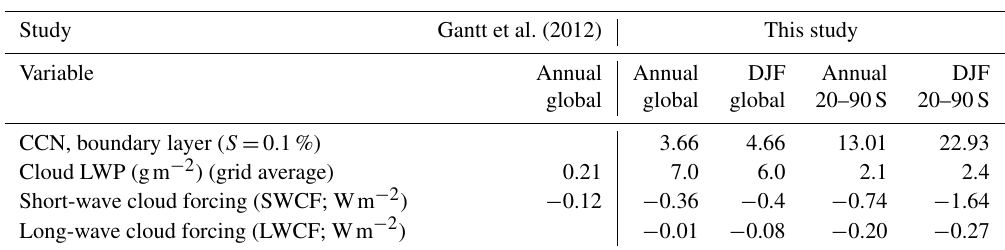
Table 5. Annual and DJF mean relative (percentage) changes in aerosols, clouds, and radiative fluxes, globally and over the Southern Ocean ( INT_ADD